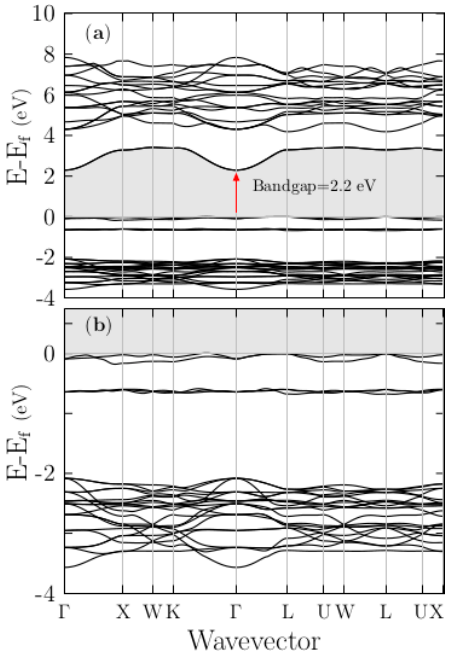
Figure 5. The upper panel ( a ) shows the calculated Kohn–Sham folded band structure of SC K 7 Cl 8 :Cu for the case of Figure 1c and along the same high-symmetry directions of the BZ used in the PC. The lower panel ( b ) shows a zoomed region in the energy range of 4.0 to 0.5 eV. The lowest direct